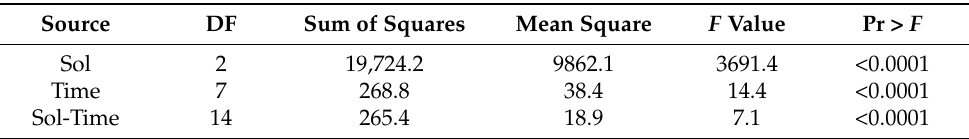
Table 5. ANOVA for NH 4 concentrations eluted from the treated carcass with regard to zeolite amendment and elution